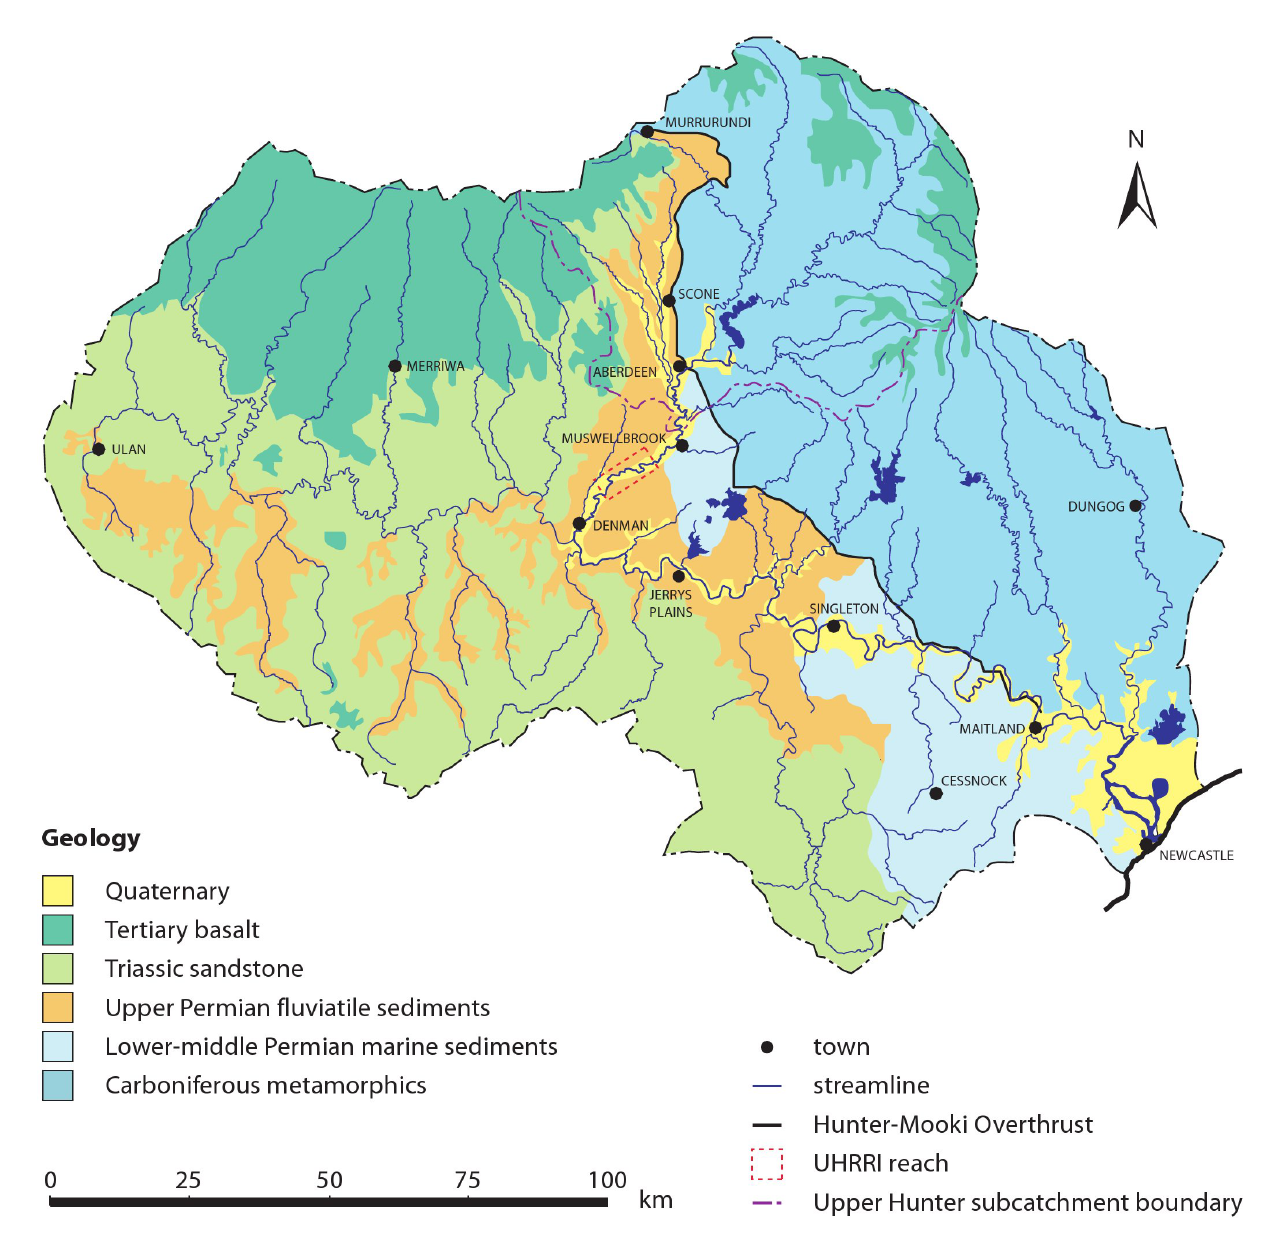
Fig. 2 . Geology of the Hunter catchment (modified from DLWC